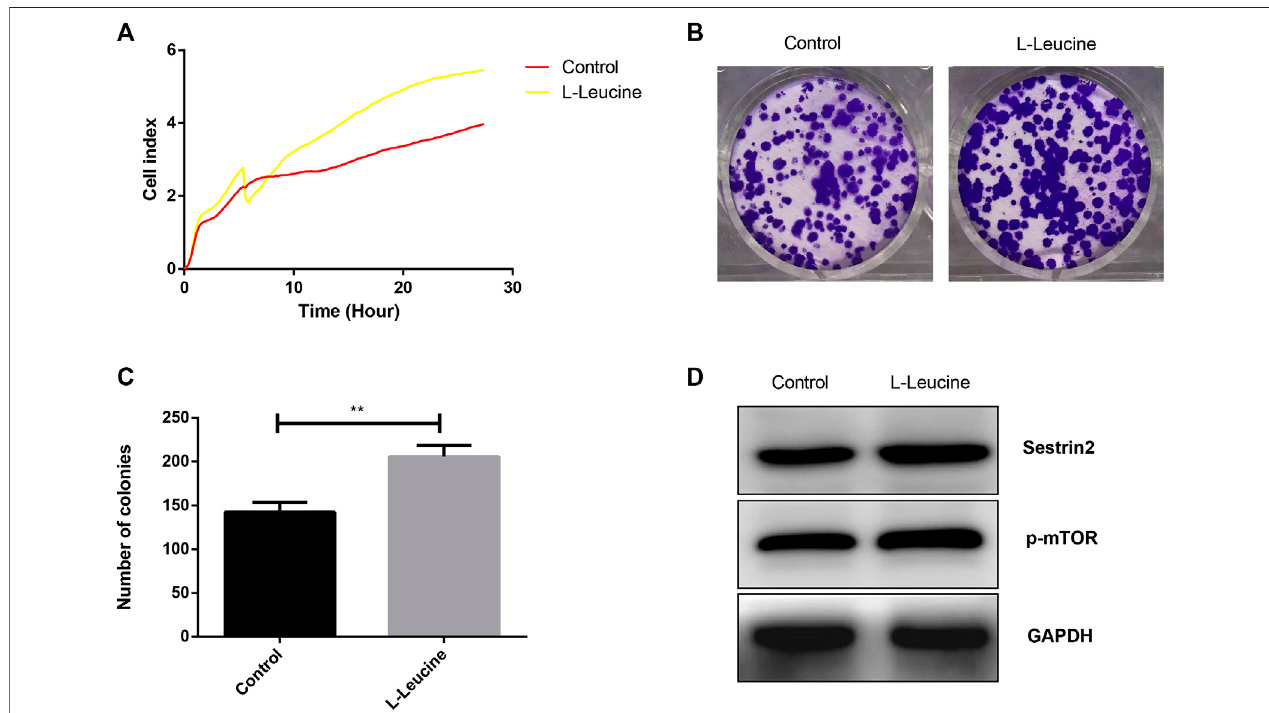
FIGURE 1 | L - Leucine promotes growth and proliferation of PANC-1 cells. (A) RTCA assay. Cells were treated with 50 μ M L - leucine and cell index were automatically recorded every 15 min. (B) Colony formation assay. Cells were treated with 50 μ M L -leucine and incubated for 14 days. (C) Statistical bar chart of the number of clones. (D) Western blot analysis of Sestrin2 and p-mTOR. ** p < 0.01.